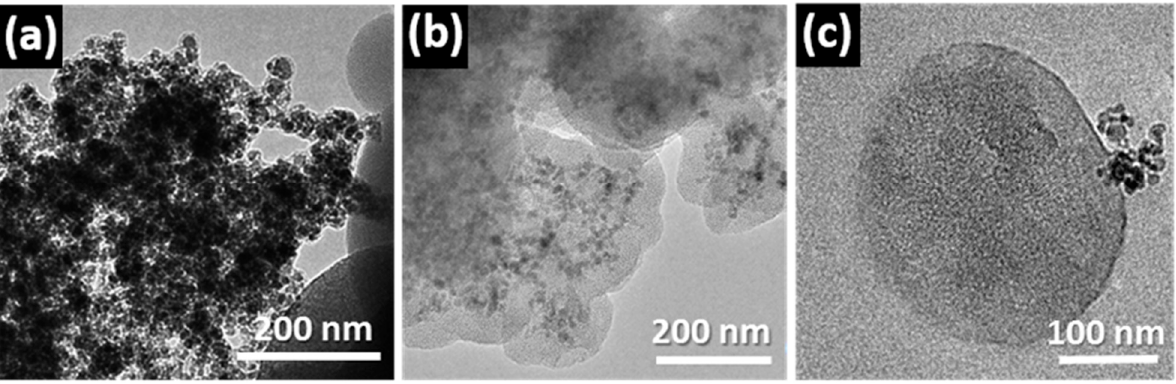
Figure 6. Low magnification TEM images of the mesoporous particles after attempting the encapsulation of ( a ) γ -Fe 2 O 3 without coating; ( b ) γ -Fe 2 O 3 -1 coated with APTEs and ( c ) γ -Fe 2 O 3 -2 coated with silica. Adapted with permission from [73]. Copyright Royal Society of Chemistry (London, UK).